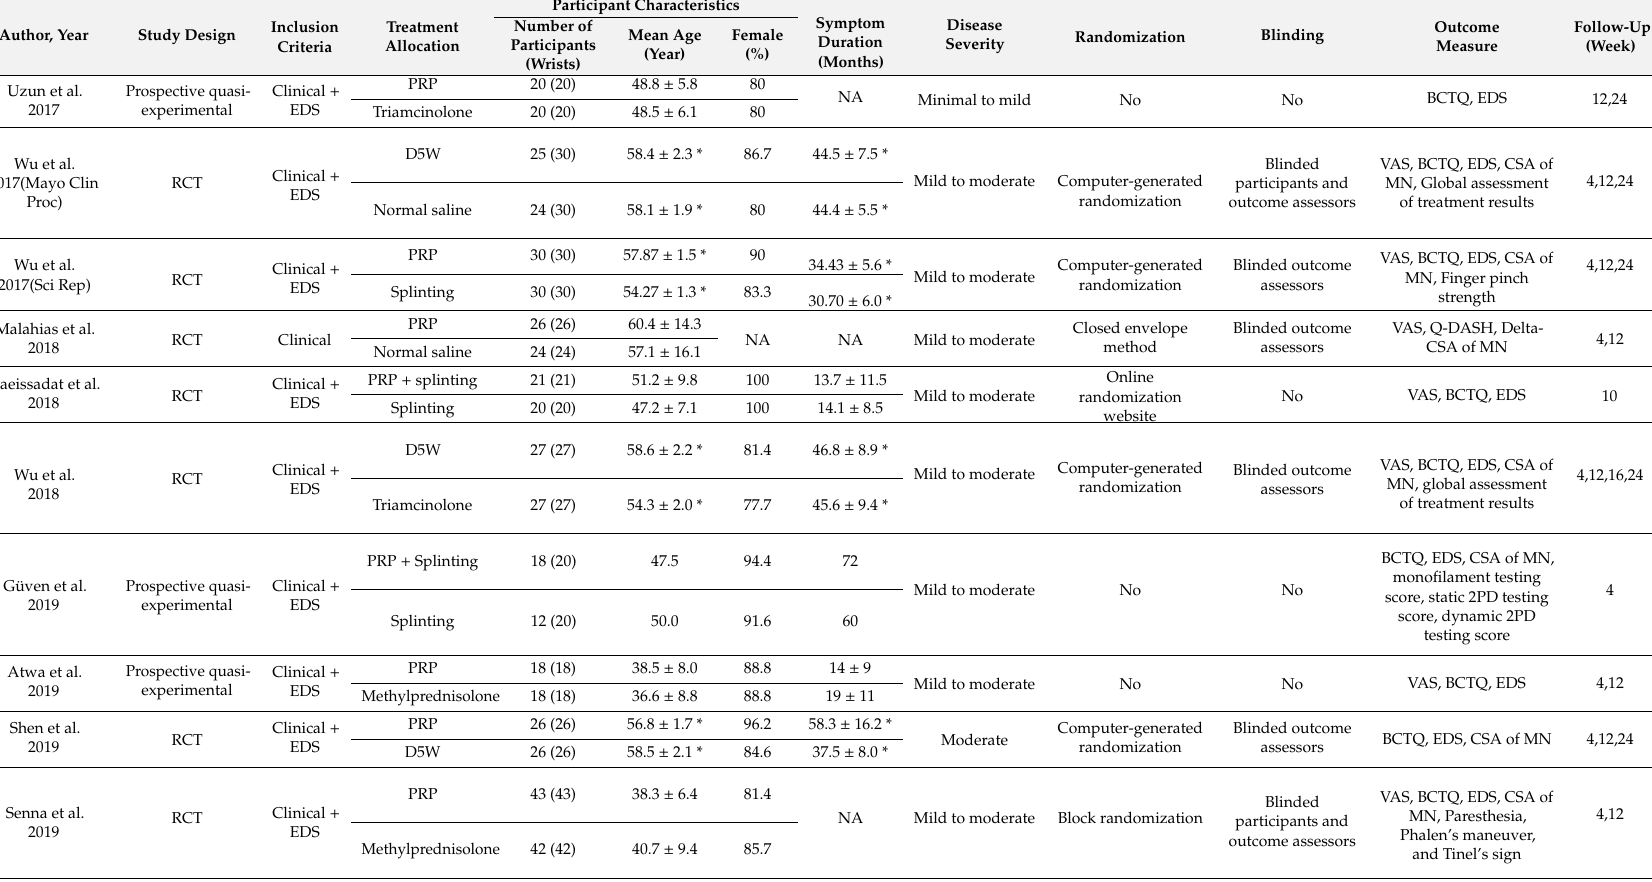
Table 1. Summary: the characteristics of included studies using regenerative injection (comprising 5% dextrose and platelet-rich plasma) for treating carpal tunnel